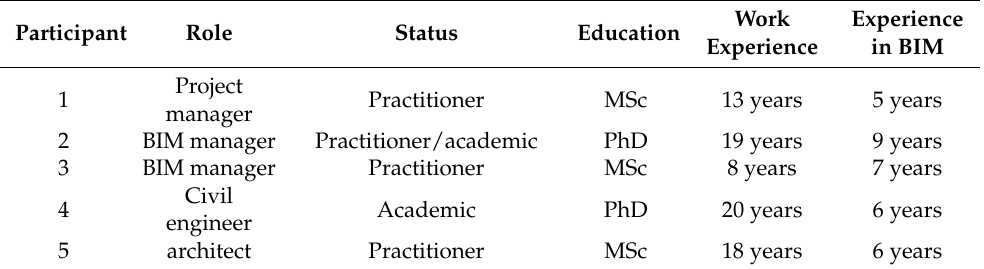
Table 4. Interviewees’ profile.